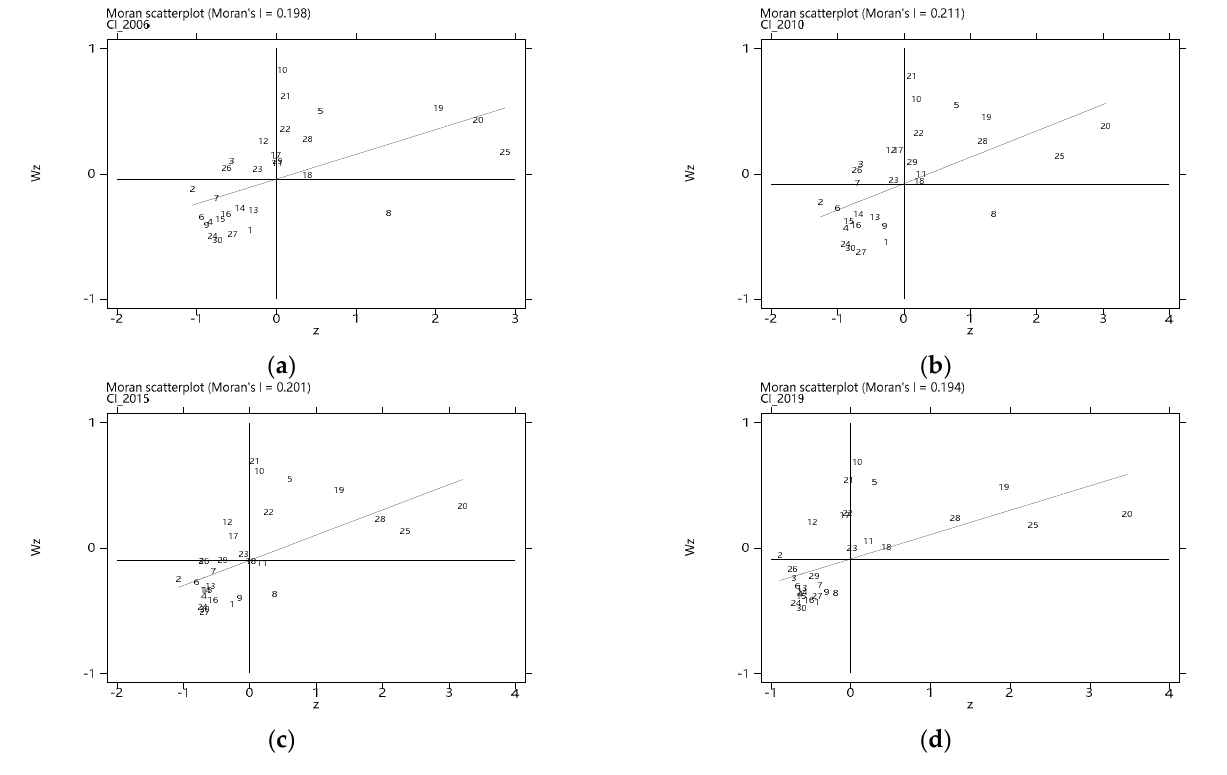
Figure 5. ( a – d ) Moran scatterplots of carbon intensity in 2006, 2010, 2015,